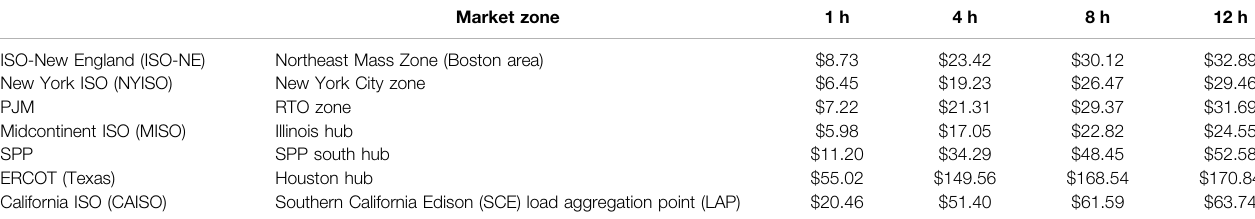
TABLE 3 | Energy time-shift value ($/kW/year) in the U.S. wholesale markets in 2019, selected zones, multiple